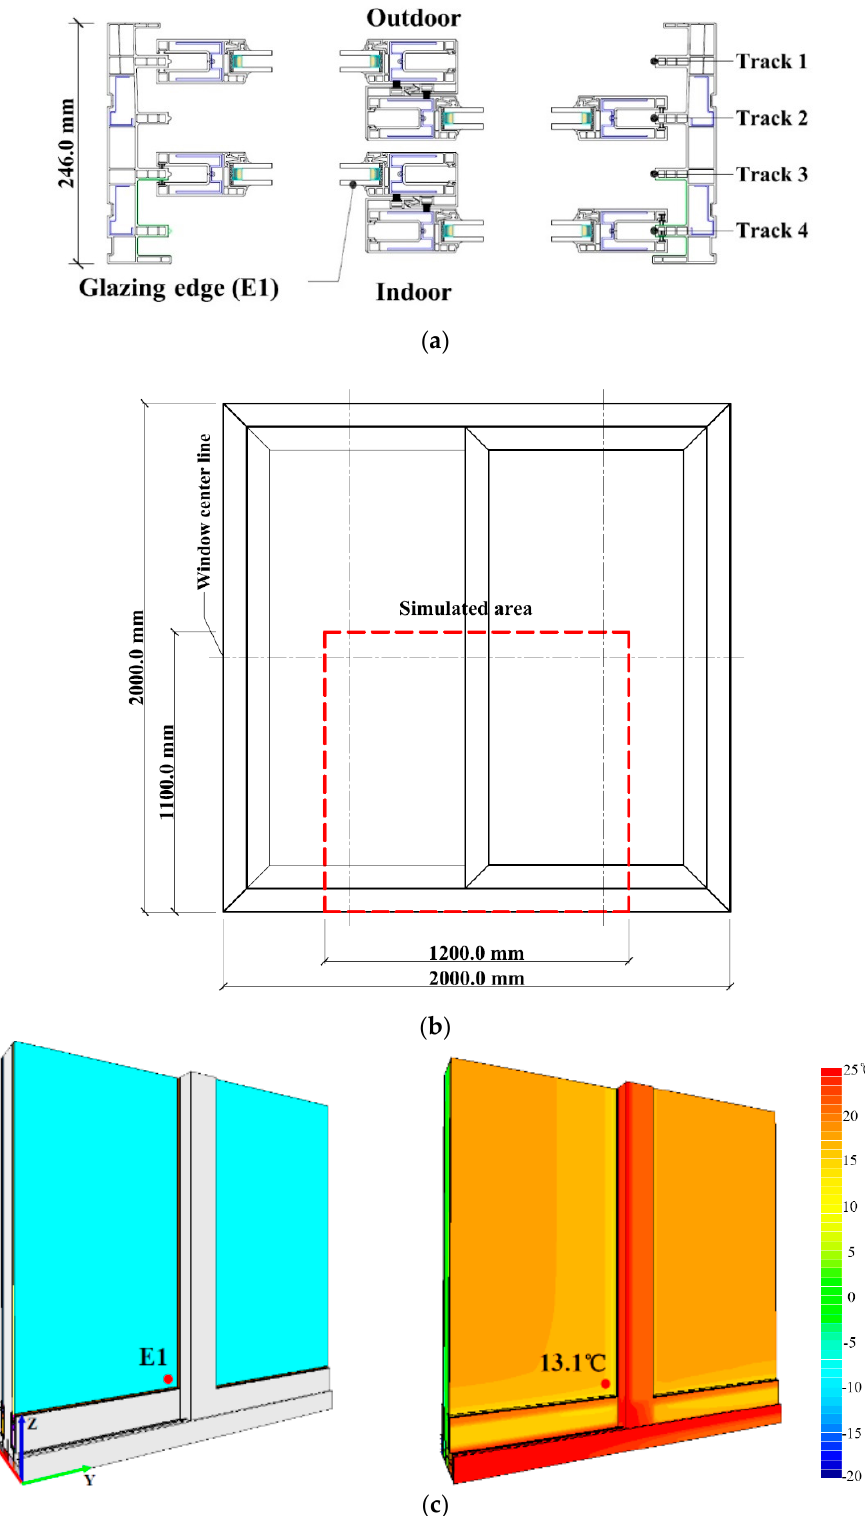
Figure 7. Section, area and model for TDR simulation: ( a ) simulated section; ( b ) simulated area; ( c ) simulation model (Case 1-0).